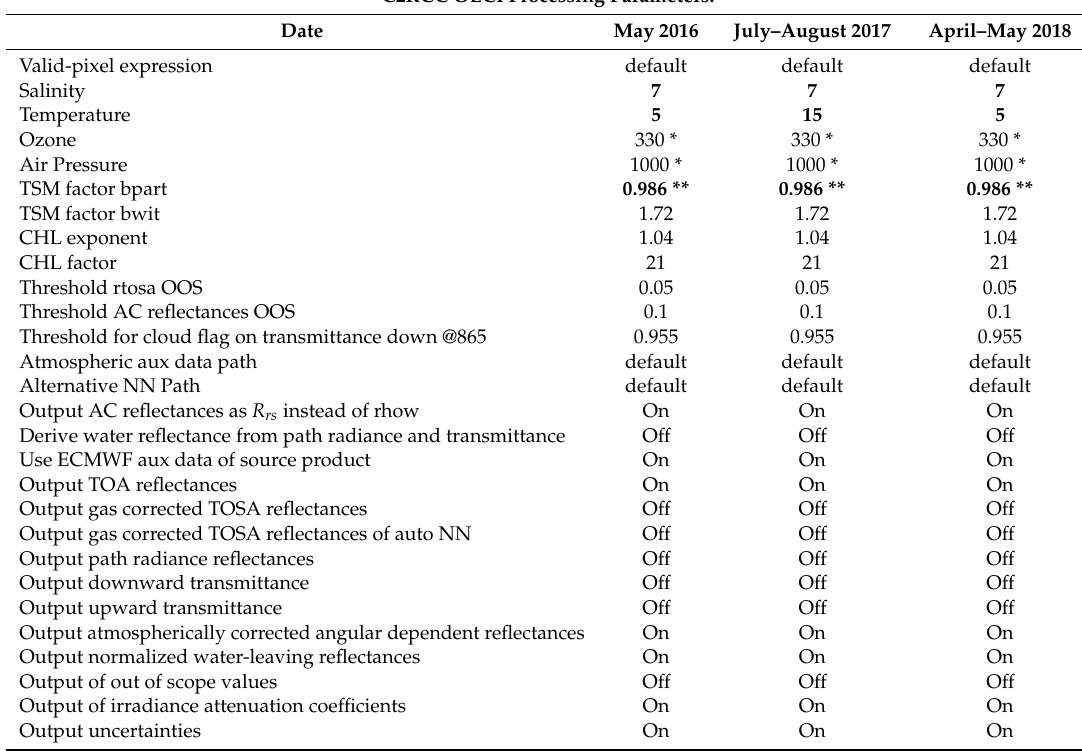
Table 4. C2RCC OLCI processing parameters used for processing match-up scenes during validation campaigns 2016–2018. * indicates parameters that are automatically imported from L1b data and used for processing. Values listed in bold were adjusted to specific Baltic Sea conditions. ** derived in ref. [23]. C2RCC OLCI Processing